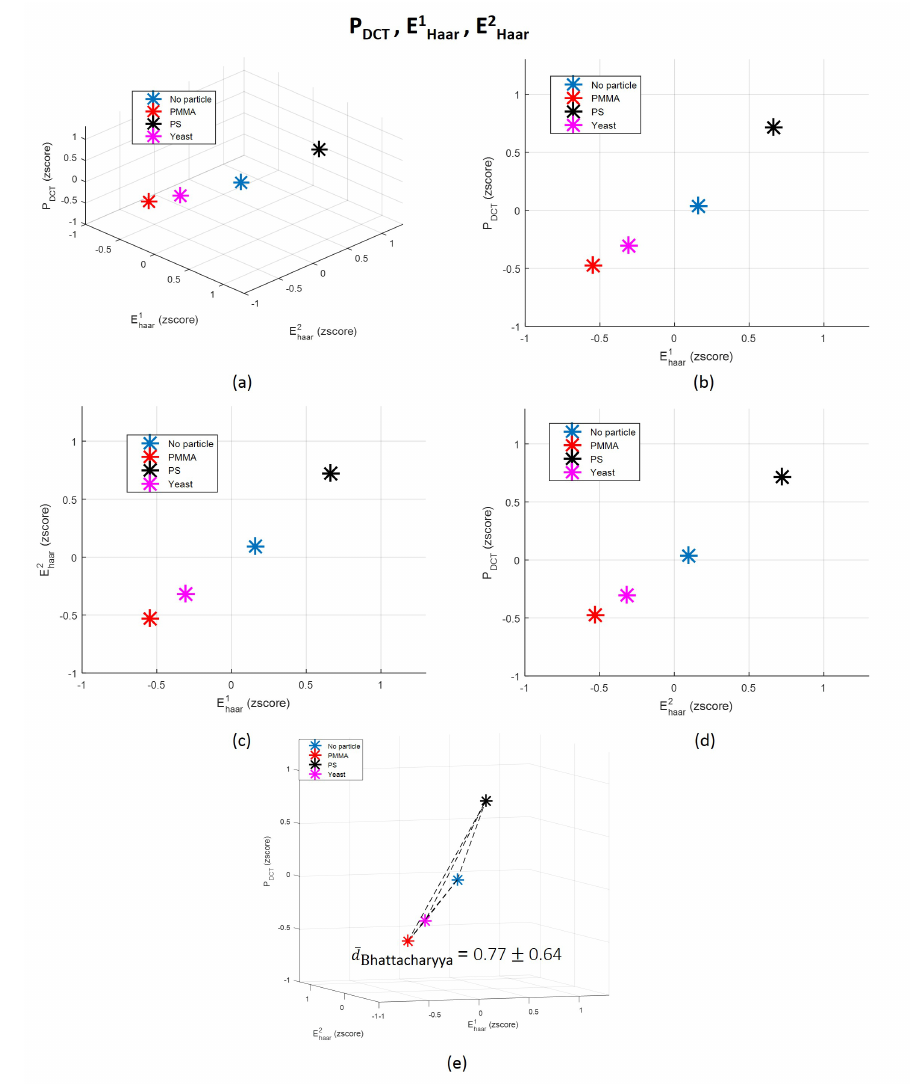
Figure 12. ( a ) 3-dimensional representation of the three original features ( P DCT , E 1 and E 2 ) Haar Haar which contributed the most for the final LDA-derived one; ( b – d ) 2D decompositions of the 3D space; and ( e ) correspondent average Bhattacharyya distance between each pair of classes distributions and graphical representation of each distance norm. Each point represents the mean value in the 3D space corresponding to each class: “Class 1: No particle”, “Class 2: PMMA”, “Class 3: PS” and “Class 4: = 1.32; d No particle / PS = 0.17; d No particle / Yeast = 0.12; d PMMA / PS = Yeast”. d No particle / PMMA Bhattacharyya Bhattacharyya Bhattacharyya Bhattacharyya